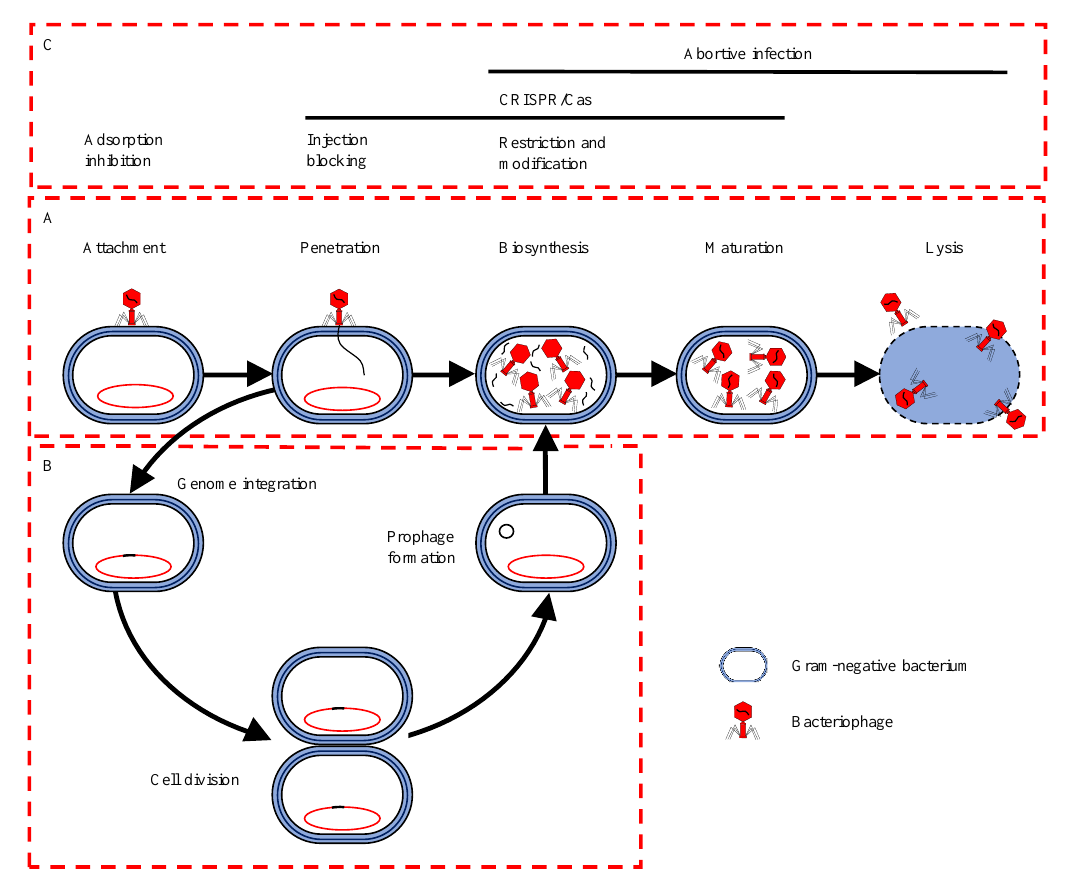
Figure 4. Schematics representation of the ( A ) lytic and ( B ) lysogenic bacteriophage life cycles and ( C ) bacteriophage resistance mechanisms, including receptor adaptations (adsorption inhibitions and injection blocking), host defence systems [clustered regularly interspaced short palindromic repeats (CRISPR/Cas)] and phage-derived defence systems (restriction and modification) (adapted from Hyman and Abedo [97]; Egido et al. [98]). The pharmaceutical and medical application of bacteriophages has also garnered renewed interest globally, due to the rise in the frequency of antibiotic-resistant bacterial infections and the limited availability of new antimicrobial compounds [99]. For exam- ple, Merabishvili et al. [42] isolated two bacteriophages, namely, vB_AbaM_Acibel004 ( Myoviridae ) and vB_AbaP_Acibel007 ( Podoviridae ), with Acibel004 exhibiting antibacterial activity towards 75% ( n = 21/28) of the A. baumannii test isolates, while Acibel007 exhibited antibacterial activity towards 60.7% ( n = 17/28) of the isolates analysed. Correspondingly, Asif et al. [100] isolated a Myoviridae